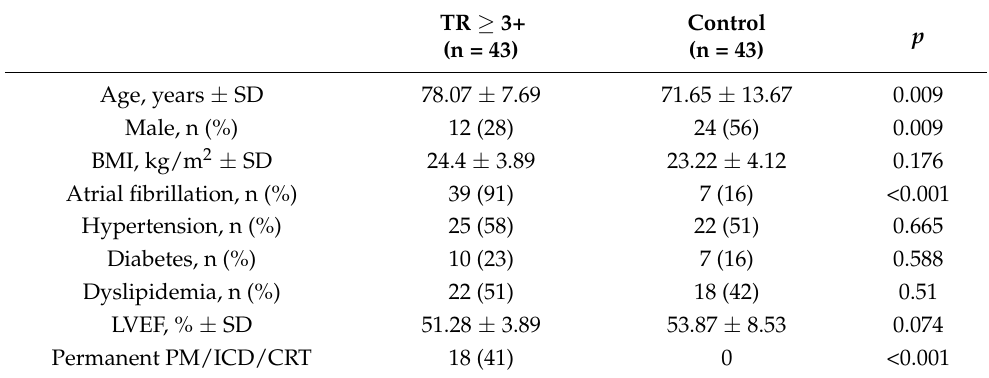
Table 2. Baseline clinical characteristics.